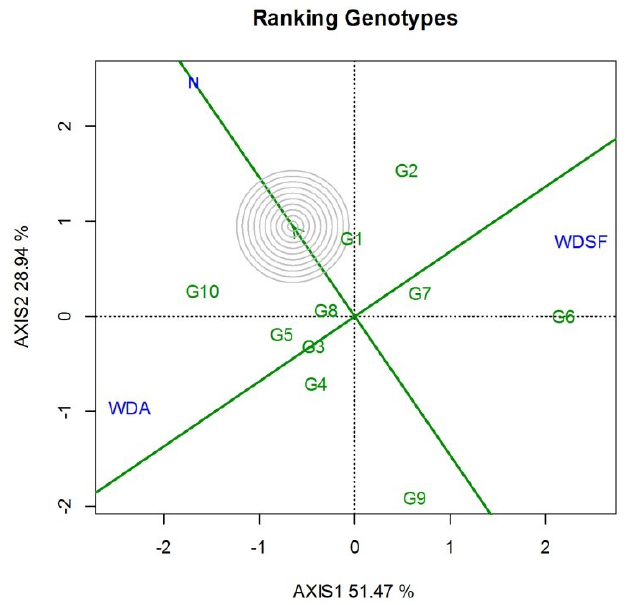
Figure 2. GGE biplot for ranking the ten bean genotypes with the “ideal” for seed yield and stabil- ity, based on the three irrigation levels (N, normal irrigation; WDA, water deficit at anthesis; WDSF, water deficit at seed filling stage) for two years (2014 – 2015). The center of the concentric circles represents the position of an ideal genotype. An ideal has both high mean seed yield and high stability. PC1 = 51.47, PC2 = 28.94, Sum = 80.41.